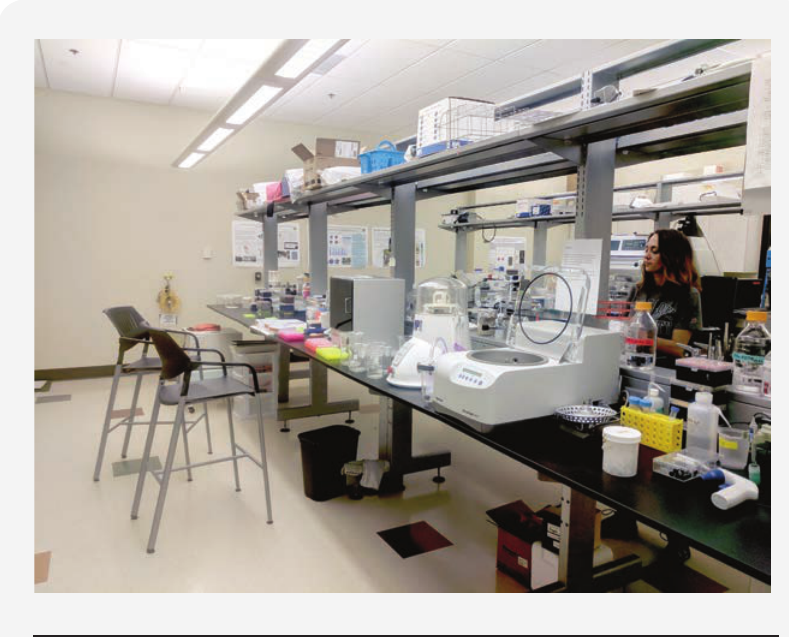
Figure 3. The conservation genetics laboratory at MBG. The lab is dedicated to conservation genetics and has the equipment necessary for DNA and RNA extraction, gel electrophoresis, DNA and RNA quantifi cation, polymerase chain reaction (PCR), and next-generation sequencing library preparation. Photo by Christine